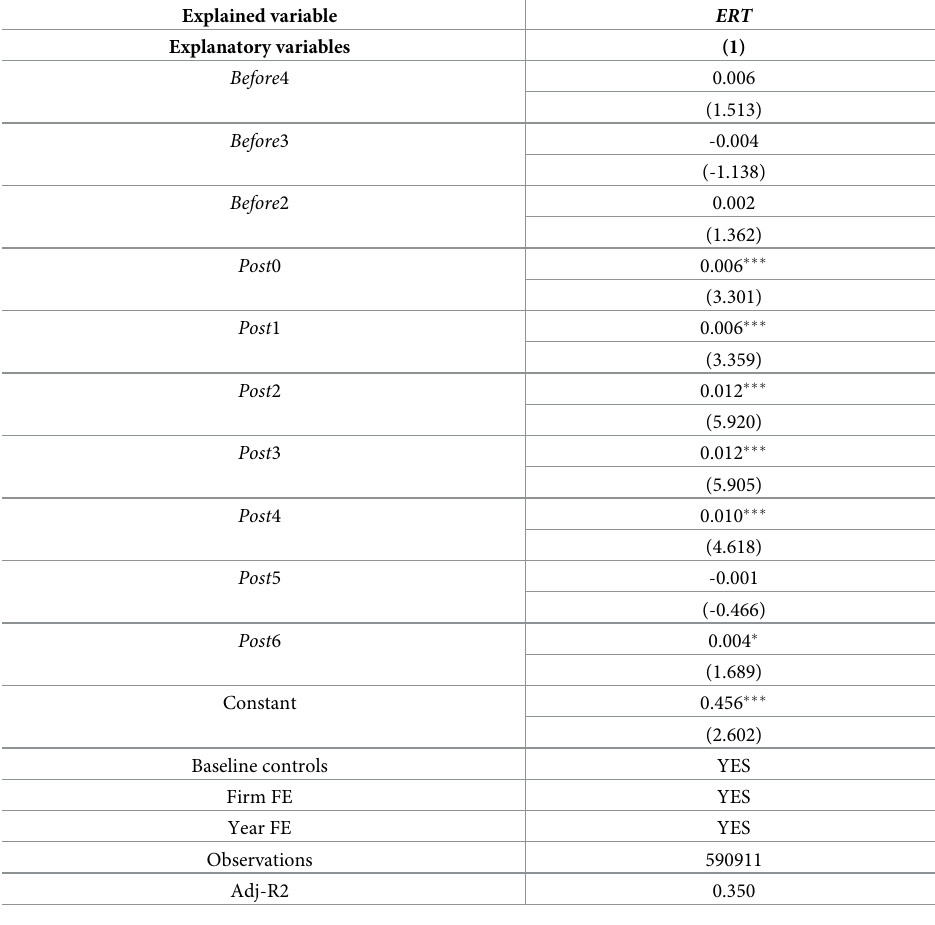
Table 3. Parallel trend test-event analysis